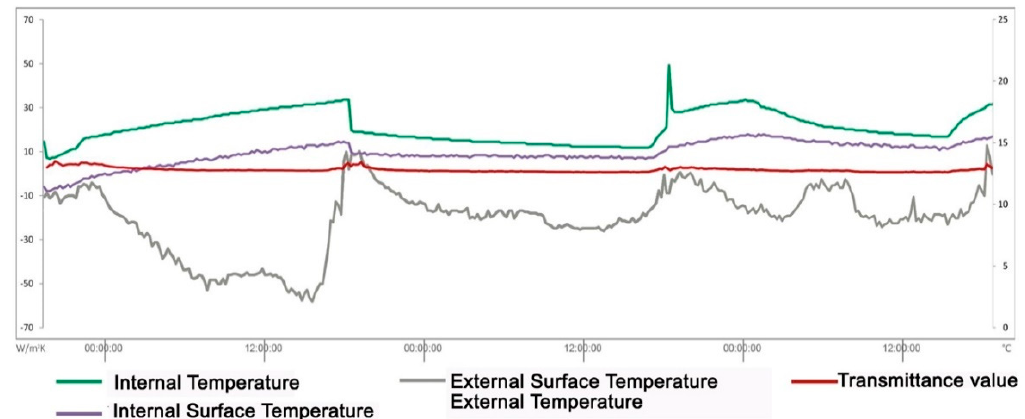
Figure 8. Part of the data detected by the thermal flux meter. Graphical output.